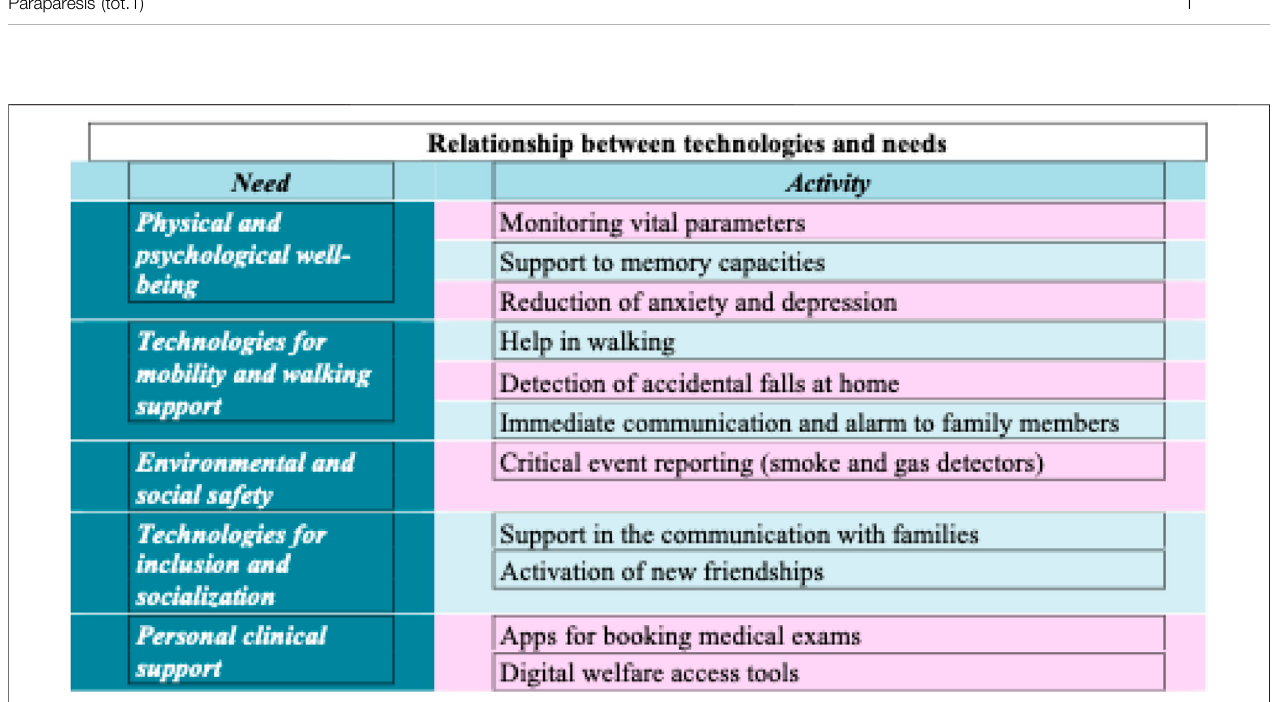
FIGURE 3 | Relationship between technologies and